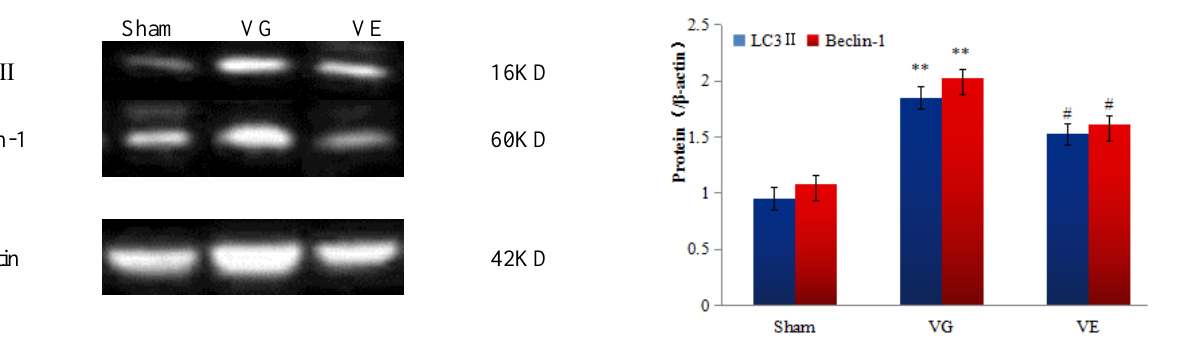
Figure 2. Western blot results of LC3 Ⅱ and Beclin-1 in the hippocampus of the rats in each group. Note: ** p < 0.01, VS Sham, # p < 0.05, VS VG.